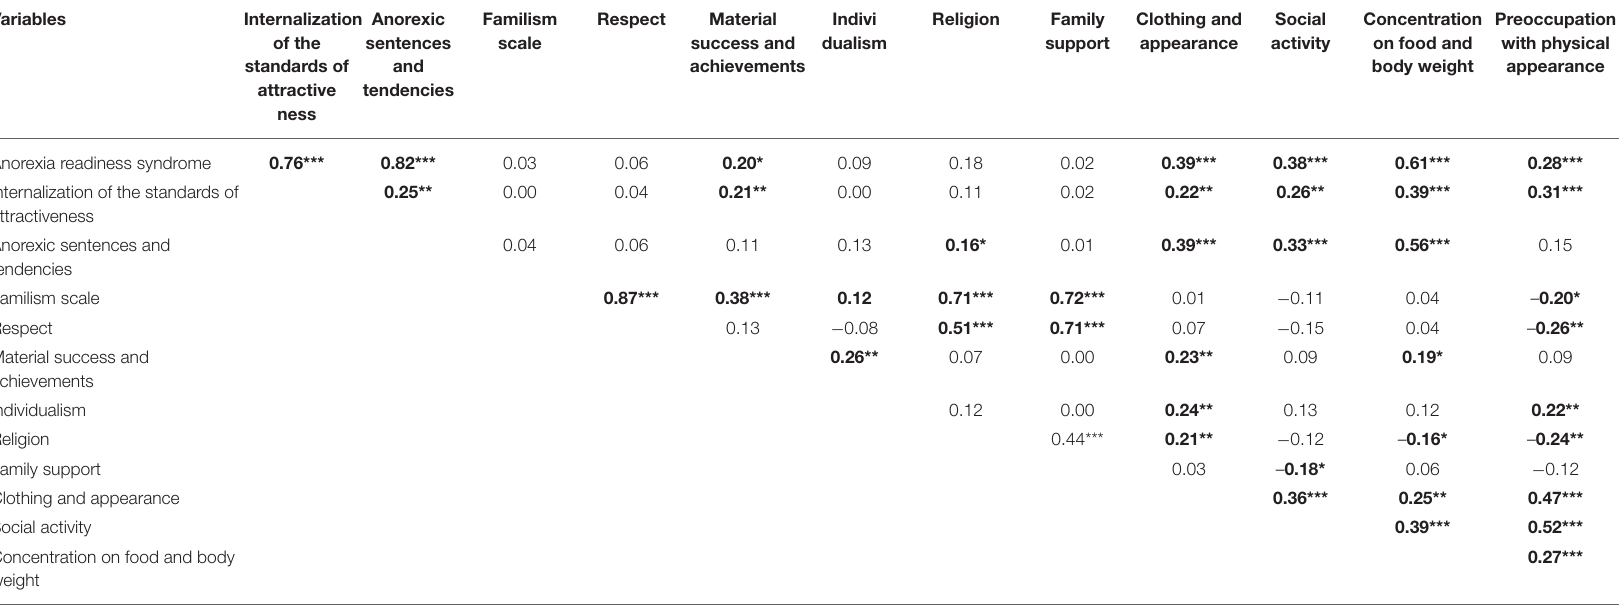
TABLE 3 | r-Pearson correlation coefficient of the examined variables ( N =